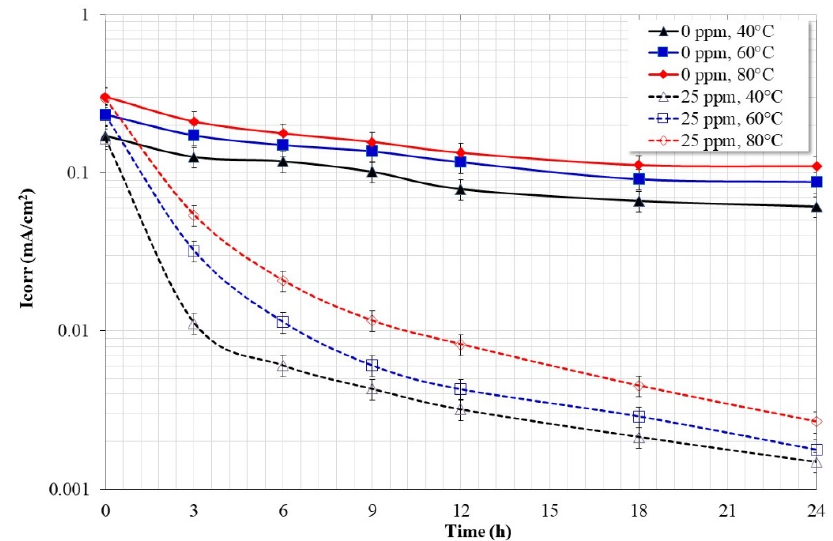
Figure 13. Corrosion current density variation for API-X52 steel in 3% NaCl solution saturated with CO 2 , determined from potentiodynamic polarization curves.